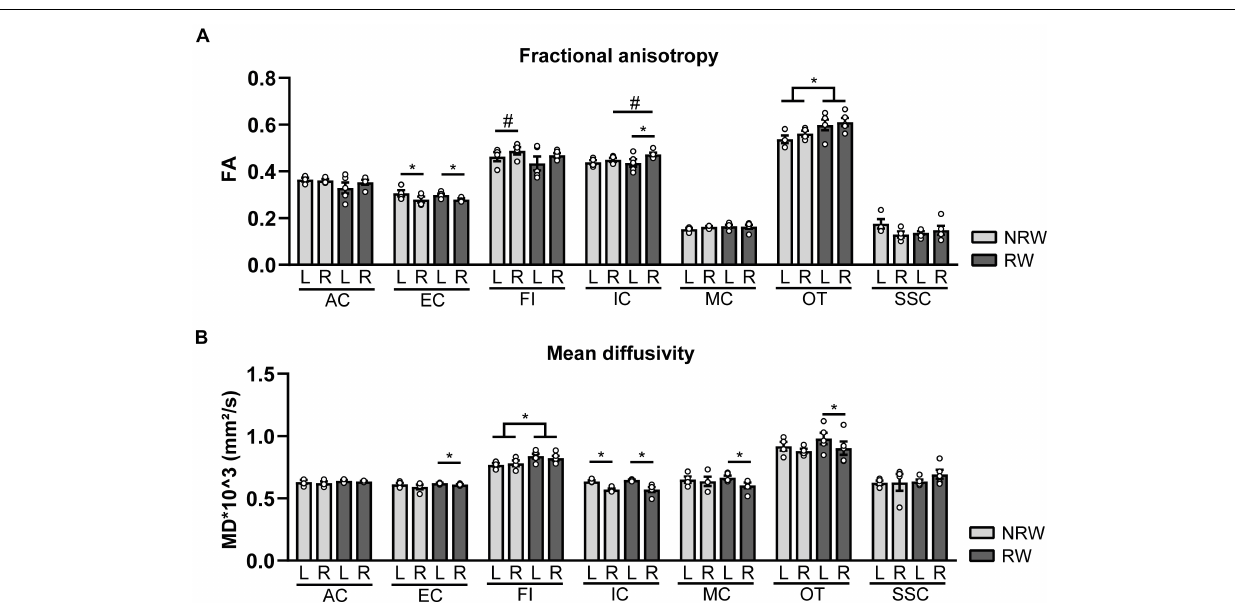
Figure 10A representative images of the GLUT-1 staining are shown. The amount of GLUT-1 measured in the thalamus was higher in RW mice compared to NRW animals ( Figure 10B : F (1,8) = 5.5, p < 0.047). Higher GLUT-1 levels were observed in the stroke affected (ipsilateral) thalamus (RW: F (1,4) = 10.3, p < 0.058), basal ganglia (RW: F (1,4) = 12.2, p < 0.025), and cortex (NRW: F (1,4) = 9.3, p < 0.038) when compared to the corresponding control (contralateral) ROI Figure 10B